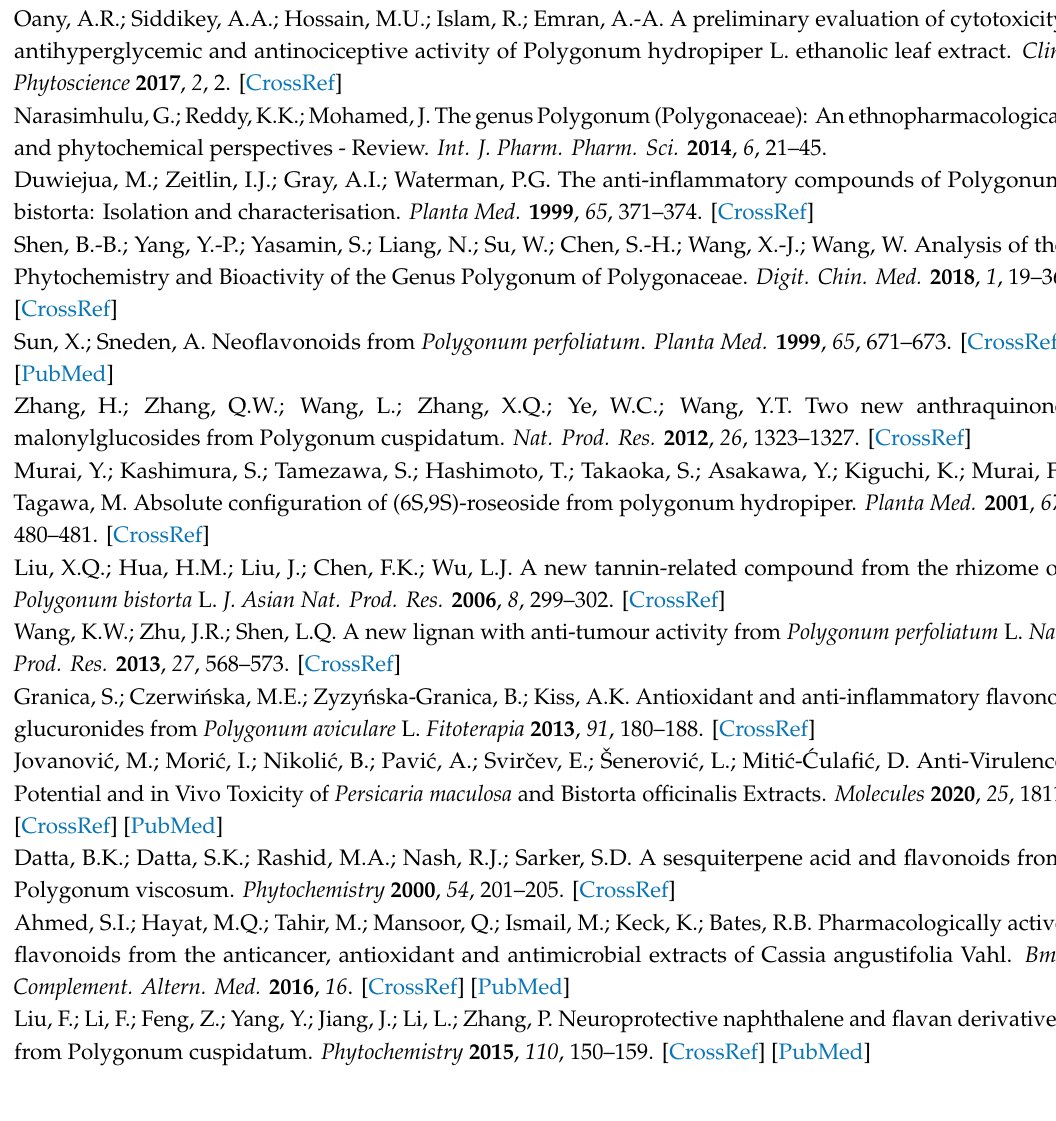
Figure S2: Leaf consumption by Pseudaletia adultera